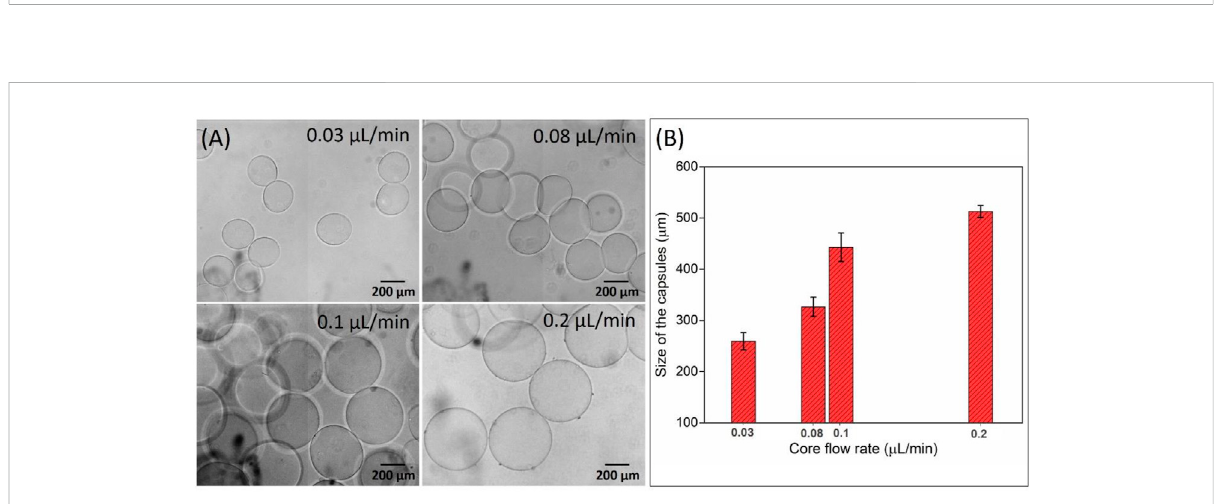
In fl uence of the Q Core on the size of the hydrogel capsules collected by the settling collection method. (A) Optical microscope images and (B)